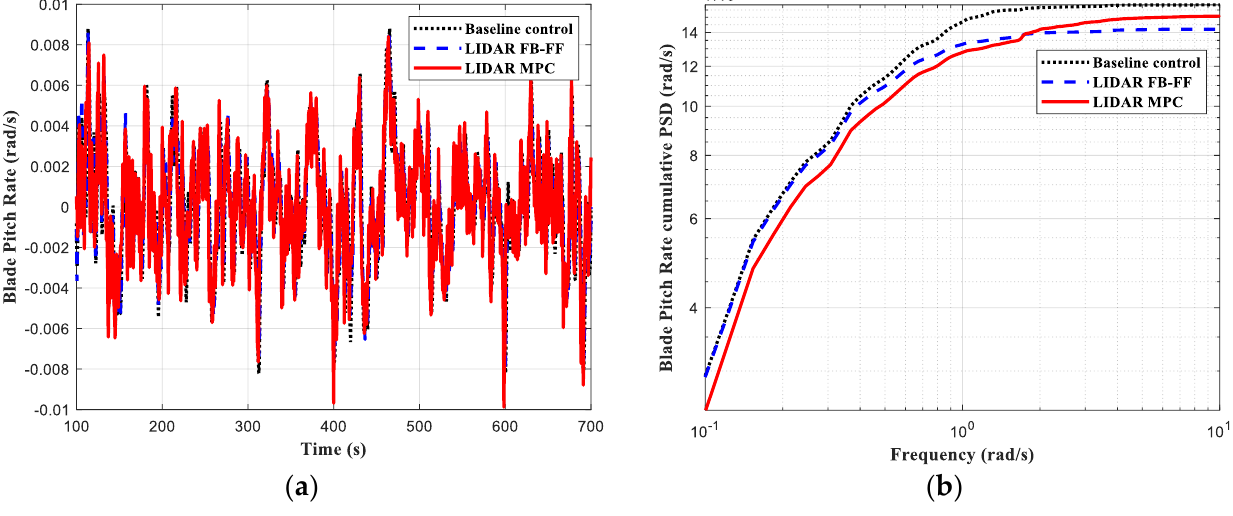
Figure 10. Comparison of the generator speed (wind speed with 10% turbulence intensity).